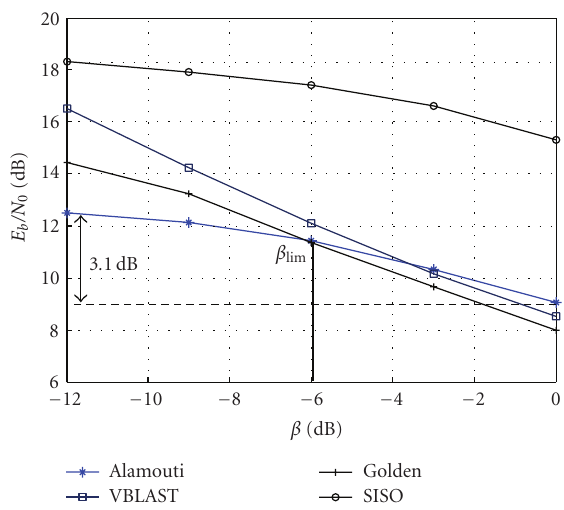
Figure 6: Required E b /N 0 to obtain a BER = 10 − 4 , single-layer case, η =